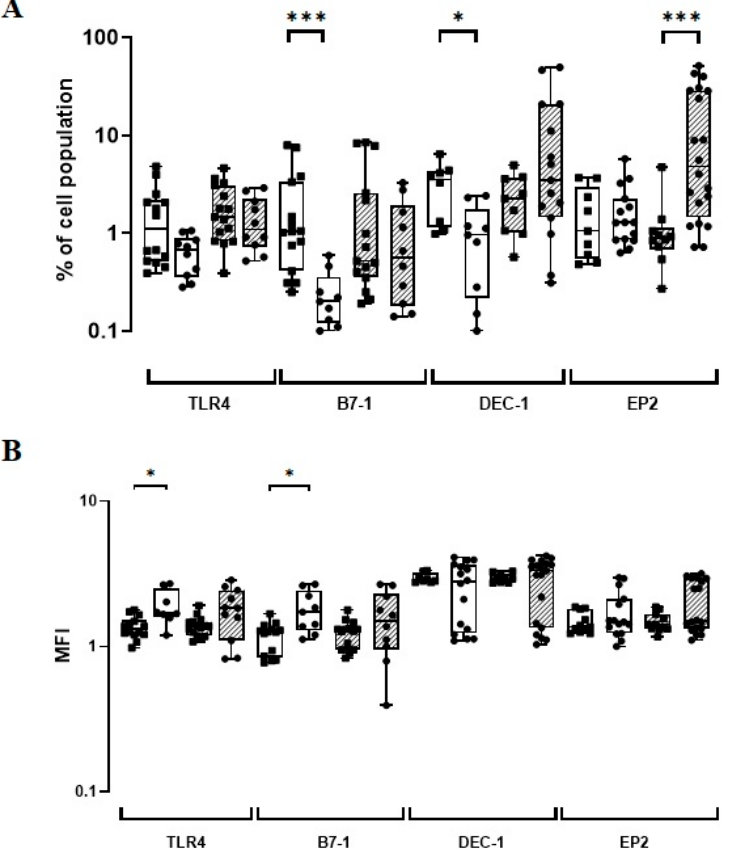
Figure 2. ( A ) The TLR4, B7-1, DEC-1, and EP2-phenotypic marker expression levels (%) induced in vitro by BCG Moreau (hatched) and baseline (opened) at 72 h (EP2) or 48 h (others) on human mononuclears from healthy adult (dot) and neonate (square) individuals. Box and whisker plots denote the median and interquartile range phenotypic marker expression values in each condition. ( B ) The same as for ( A ), except for the phenotypic marker intensity (MFI) induced under similar conditions. * p ≤ 0.05; *** p < 0.001.